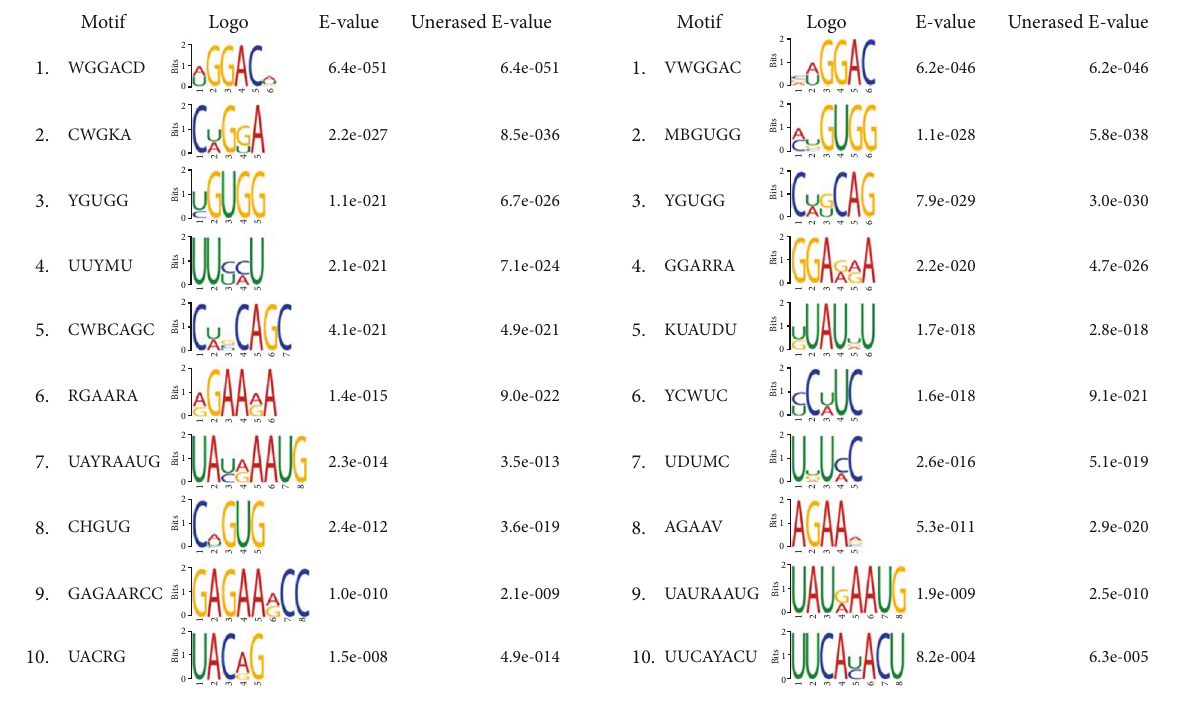
Figure 2: M 6 A-speci fi c peak sequence motif analysis. In genetics, a sequence motif is a widespread nucleotide or amino acid sequence pattern. In the apparent data analysis, a speci fi c base sequence with a high a ffi nity to certain proteins was generally de fi ned as a motif. M 6 A-speci fi c motif meant a speci fi c base sequence RNA which was modi fi ed by m 6 A. The name of the motif was created using the IUPAC codes for nucleotides which had dissimilar letters to express the 15 probable assemblies. The name itself was an expression of the motif although the position weight matrix was not diametrically synonymous as it was produced from the sites that were found to match the letters given in the name. The E -value was the enrichment P value multiplied by the number of candidate motifs tested. The enrichment P value was calculated using Fisher ’ s exact test for the enrichment of the motif in the positive sequences. The counts used in Fisher ’ s exact test were made after the erasing of the sites that matched the previously found motifs. Unerased E -value was the E -value of the motif calculated without erasing the sites of the previously found